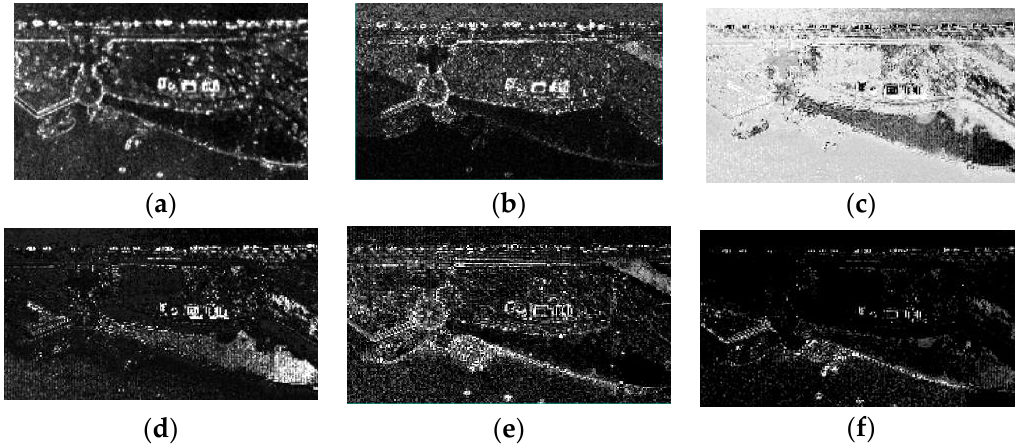
Figure 11. The target detection results of the different methods on the buoys data set. ( a ) RXD; ( b ) SegRX; ( c ) LRASR; ( d ) LSMAD; ( e ) LELRP-AD; and ( f ) EaSLRP.